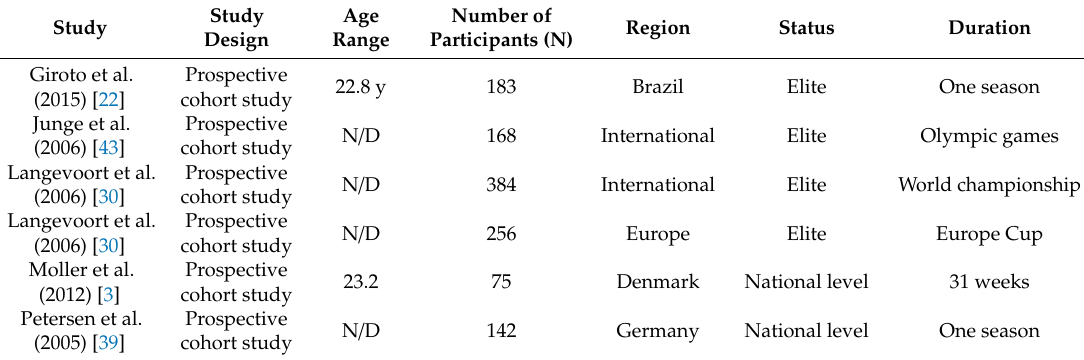
Table 2. Group and intervention characteristics in senior female handball players.